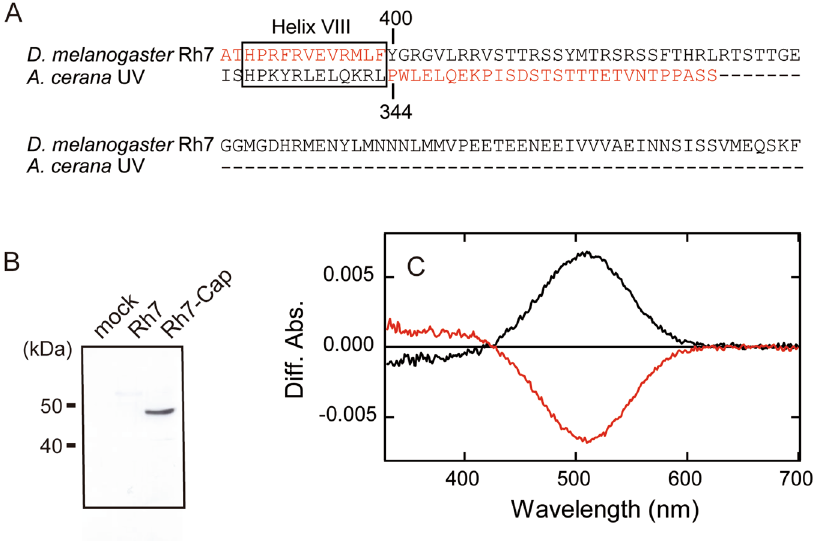
Figure 2. Construction of Drosophila Rh7-Cap. ( A ) Alignment of C-terminal region of Drosophila Rh7 and A . cerana UV light-sensitive visual opsin. The location of Helix VIII in the crystal structure of squid rhodopsin 46 is indicated by a box. The amino acid sequence from position 400 to the C-terminal end of Rh7 was substituted with the corresponding amino acid sequence (from position 344 to the C-terminal end) of A . cerana UV light-sensitive visual opsin. ( B ) Western blot analysis against the C-terminal rho1D4 epitope tag. A clear signal was detected in Rh7-Cap-transfected cells, but not in mock- or Rh7 (full-length)- transfected cells. ( C ) Photoreaction of Rh7-Cap regenerated with 11- cis -retinal. The black curve was calculated by subtracting the spectrum before irradiation from that after UV light irradiation. The red curve was calculated by subtracting the spectrum after UV light irradiation from that after subsequent yellow light ( > 500 nm)